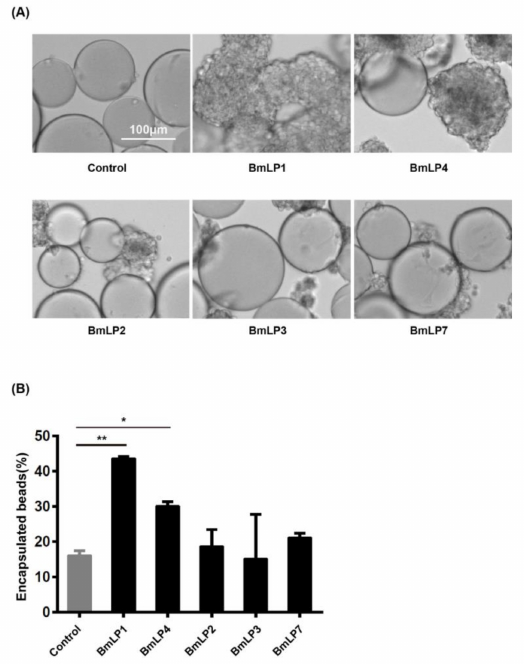
Figure 6. Encapsulation was performed using BmLP1, BmLP2, BmLP3, BmLP4, BmLP7 and no protein-coated beads ( A ). Ni-NTA agarose beads coated with recombinant BmLP1, BmLP2, BmLP3, BmLP4 and BmLP7 were incubated with hemocytes. Encapsulation of the protein-coated beads were observed by microscopy after 6 h of incubation. No protein-coated beads were used as the control. The numbers of encapsulated beads were computed ( B ). The vertical bars represent the mean ± SE (n = 2). Student’s t -test was used to calculate statistical significance. ** p < 0.01, * p < 0.1 versus the control. The error bars indicate the standard error of the mean (n = 2).